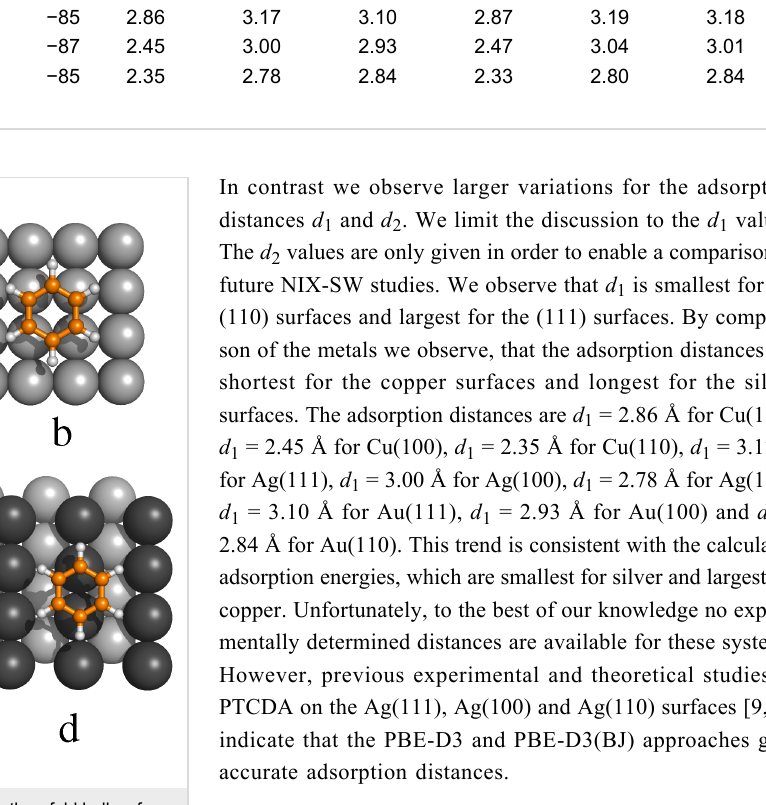
Figure 1: Preferred adsorption sites for benzene: threefold hollow for M(111) (a), fourfold hollow for M(100) (b), fourfold hollow for Cu(110) (c), and bridge for M(110) (d).